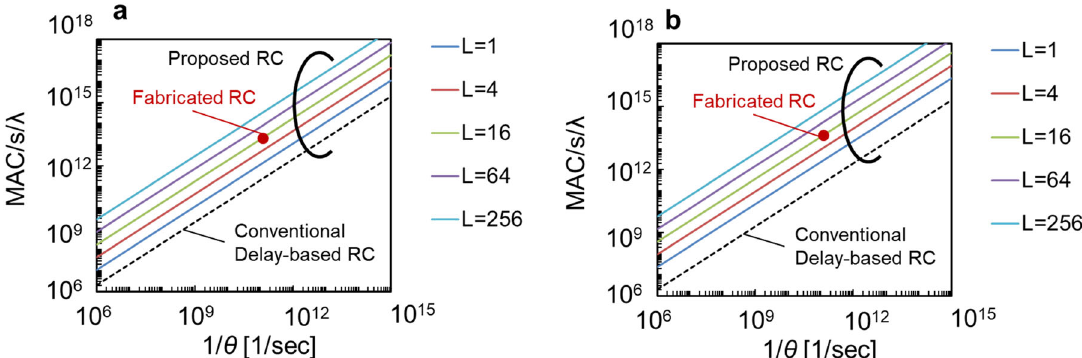
Fig. 7 Estimated processing speed. a, b Estimated multiply-accumulate (MAC) per second per wavelength λ (MAC s − 1 λ − 1 ) for proposed photonic RC as a function of 1/ θ with a M = 1 and b M =